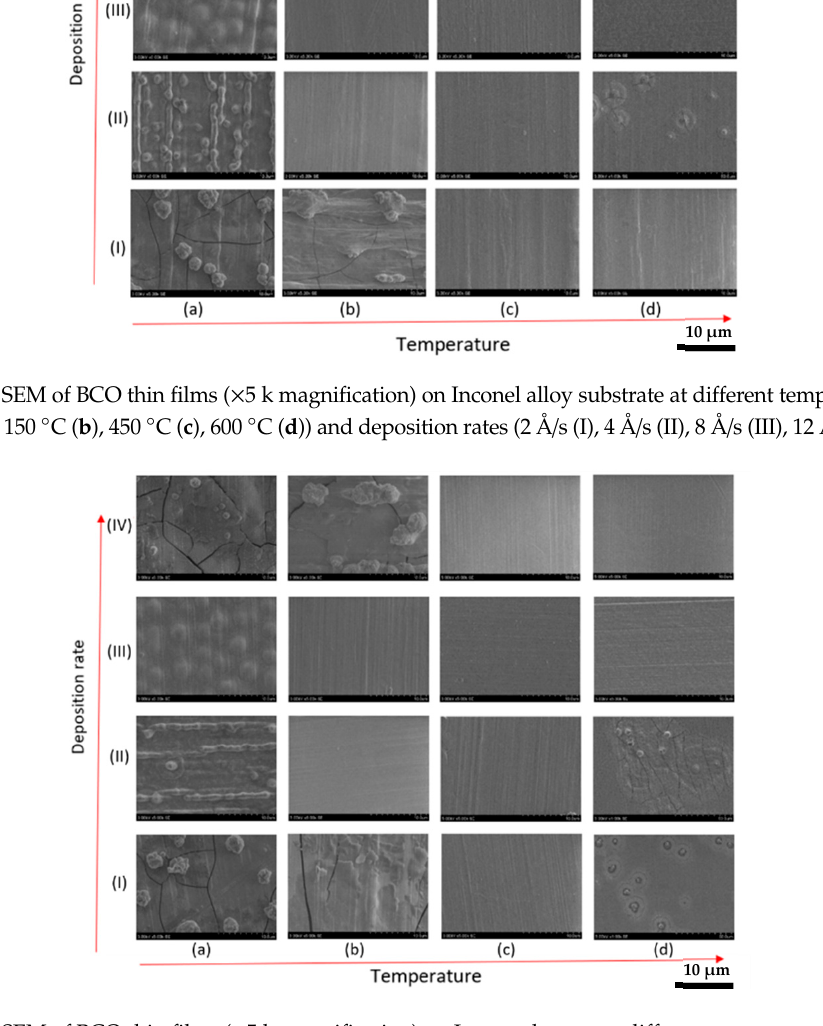
Figure 4. SEM of BCO thin films (×5 k magnification) on Invar substrate at different temperatures (20 °C ( a ), 150 °C ( b ), 450 °C ( c ), 600 °C ( d )) and deposition rates (2 Å/s (I), 4 Å/s (II), 8 Å/s (III), 12 Å/s (IV)).